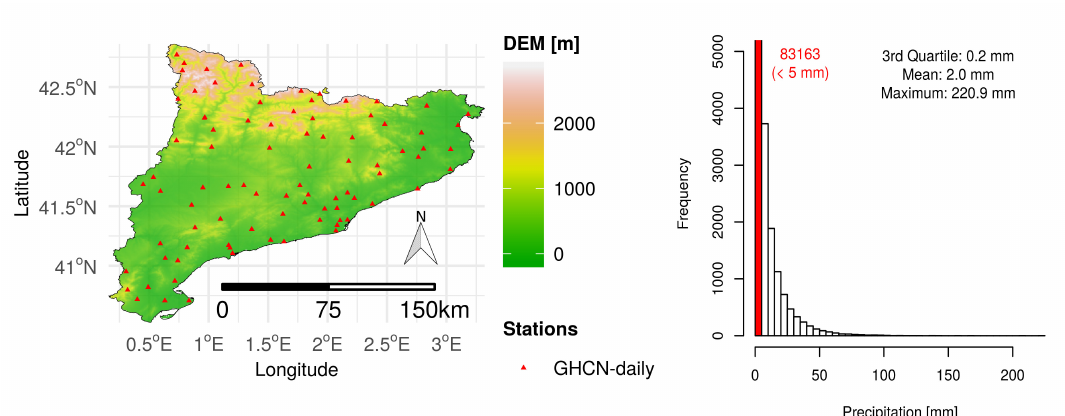
Figure 2. GHCN-daily station locations on top of a digital elevation model (DEM) of the study area ( left ) and histogram of daily precipitation for Catalonia ( right ). The histogram contains 92,404 GHCN-daily observations for the 2016–2018 period.